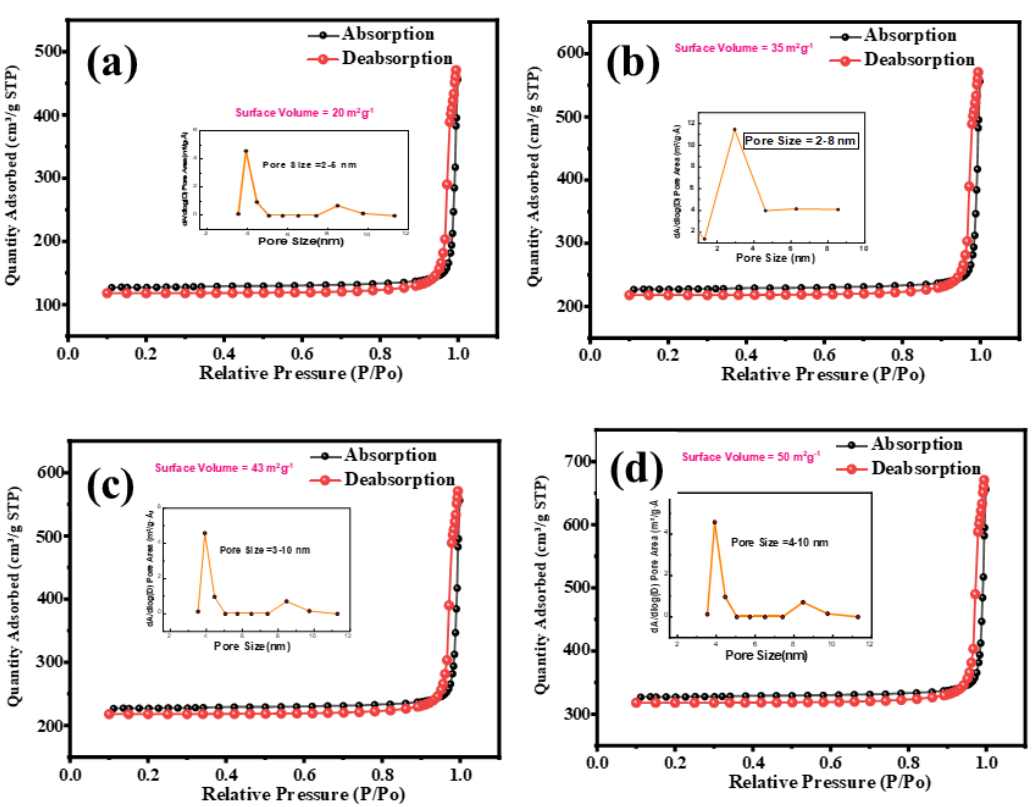
Figure 6. ( a – d ) Bet surface area analysis of NMFF1-NMFF4, inserted with pore size